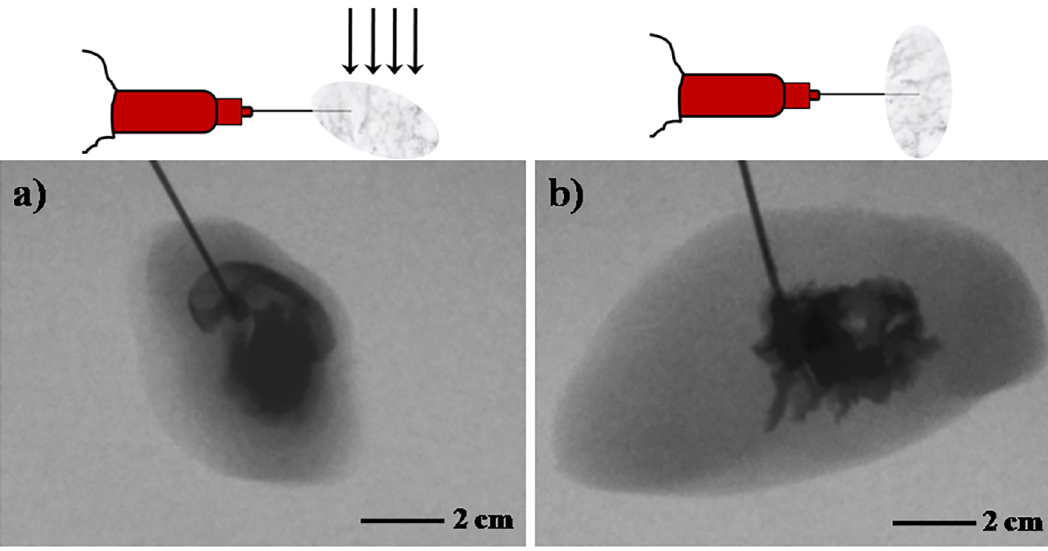
Figure 4. Contrast agent (iopamidol solution) injection scheme and radiological top view images of bacterial cellulose hydrogels under laminar injection flow: a) Pseudo-homogeneous BNC cocoon and the developed spiral-like fluid recirculation; b) Granular BNC cocoon and the percolation ramification pattern, around internal fiber granules. Down arrows represent incident X-ray bean